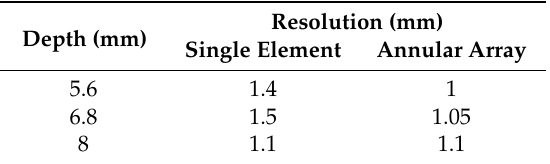
Table 2. Resolution of single element and annular